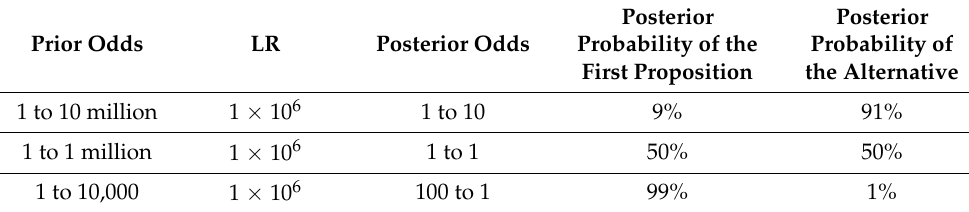
Posterior Posterior Probability of the Probability of First Proposition the Alternative